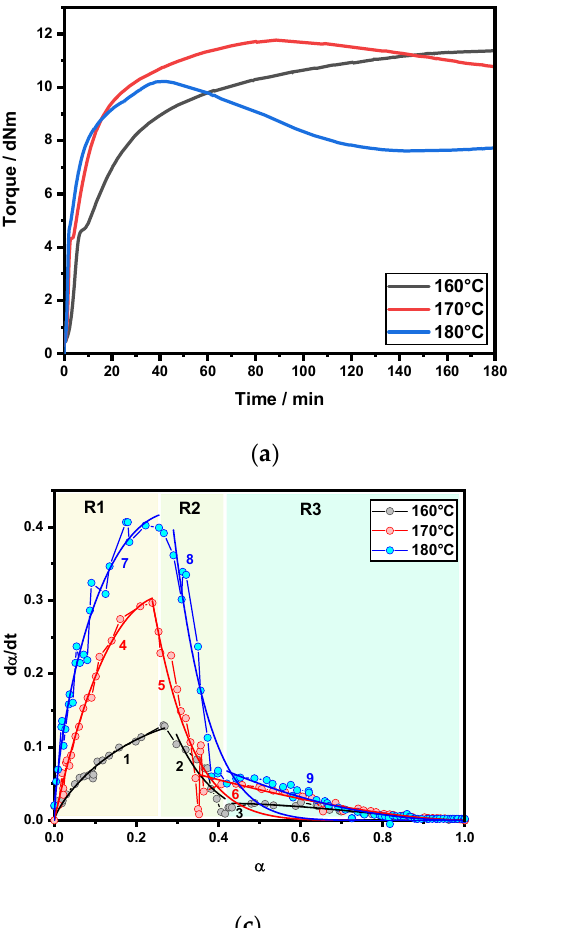
of 160 ◦ C, 170 ◦ C and 180 ◦ C; ( b ) degree of cure calculated; ( c ) autocatalytic model fitting for the domains of Reaction 1 (R1), Reaction 2 (R2) and Reaction 3 (R3); the indices from 1 to 9 are related to the fitting parameters reported in Table S2; ( d ) activation energy, E a , and pre-exponential factor k 0 obtained from the slope and intercept values, respectively, of the linear regression for three distinctive reactions occurring during curing.